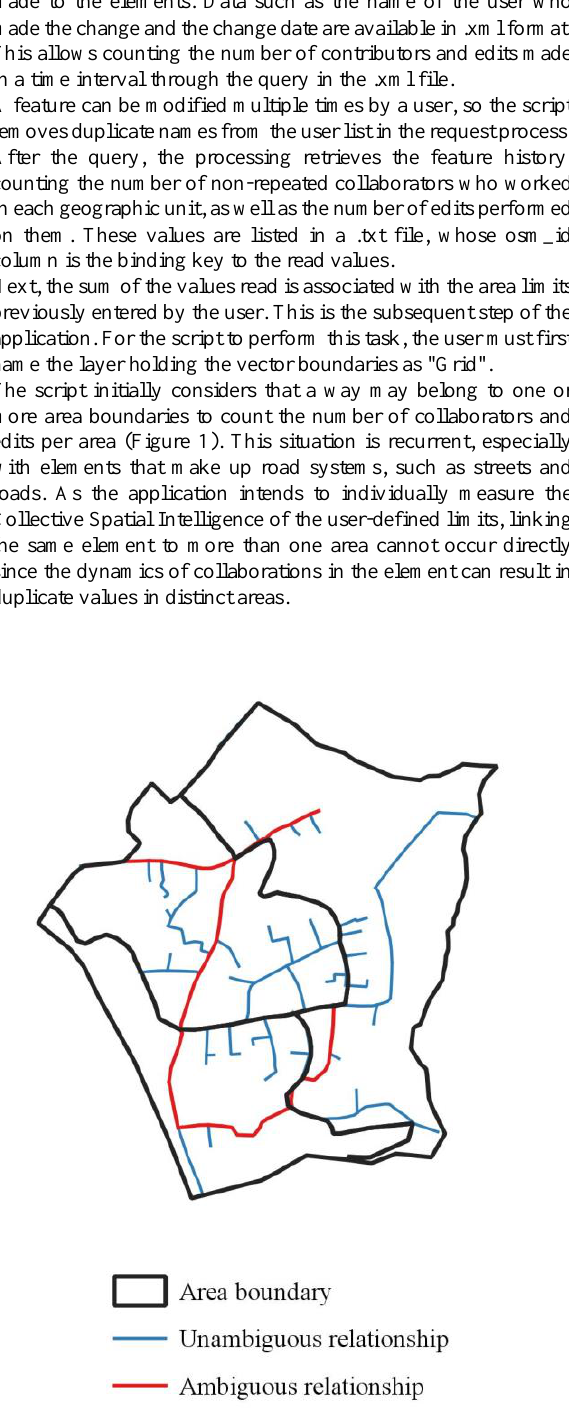
Figure 1 . Example of ambiguous relationship